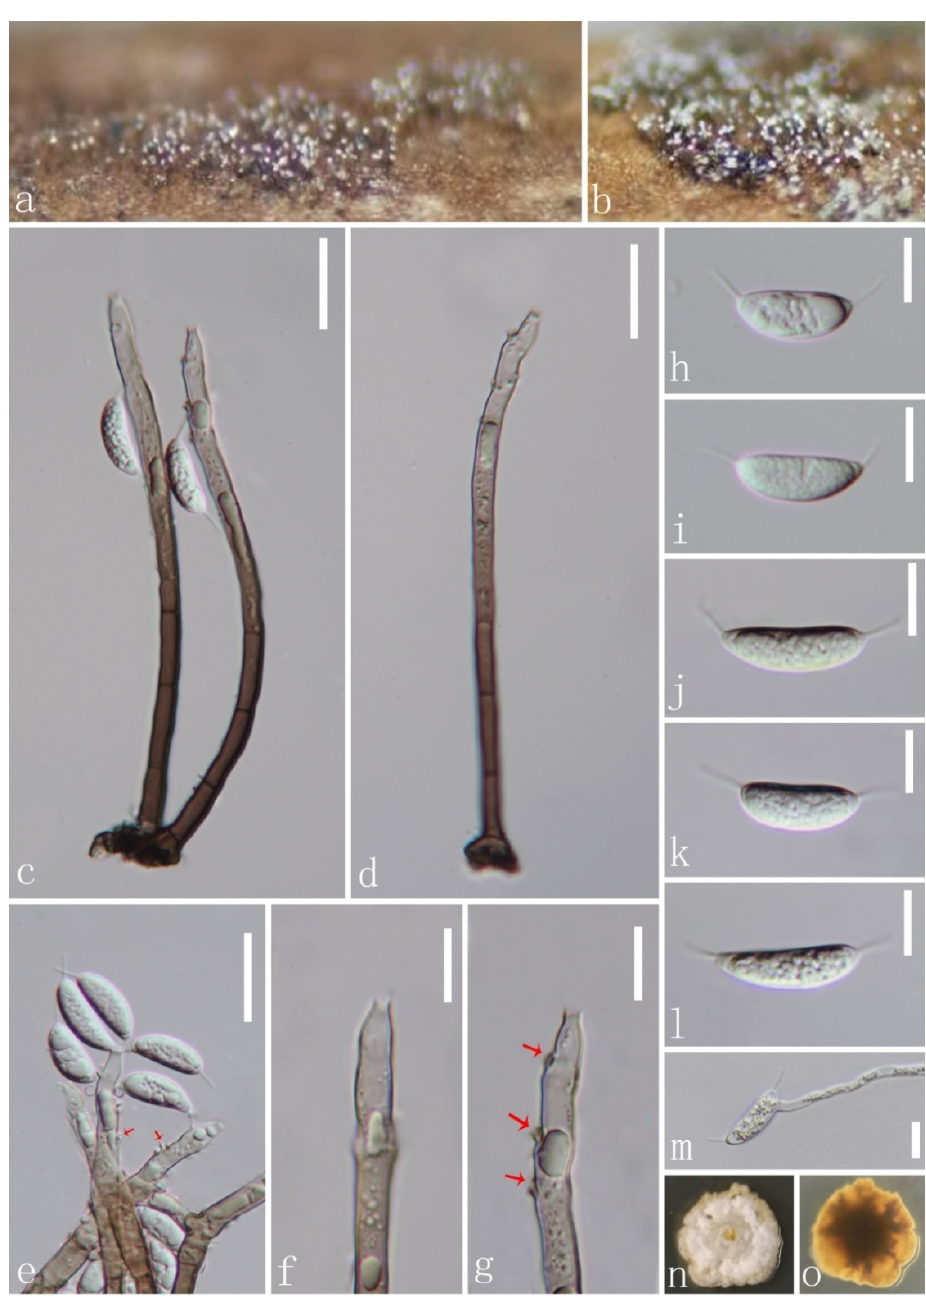
Figure 6. Codinaeella hyalina (HKAS 123757, holotype). ( a , b ) Colonies on woody substrate; ( c , d ) conidiophores and conidiogenous cells; ( e – g ) conidiogenous cells (arrows indicate collarettes); ( h – l ) conidia; ( m ) germinating conidium; ( n , o ) culture on PDA from above and below. Scale bars: ( c – e ) 20 μ m; ( f – m ) 10 μ m.